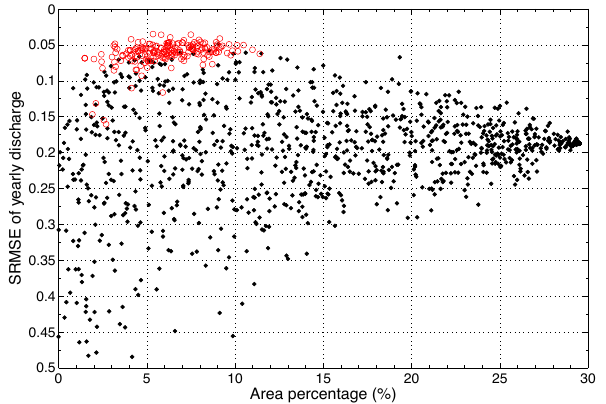
Fig. 6. Quality of discharge extrapolation measured by SRMSE of yearly discharge between gauged basin area and selected source Figure 6. Quality of discharge extrapolation measured by SRMSE of yearly discharge 3 cells, plotted against areal ratio of selected source cells to the en- between gauged basin area and selected source-cells, plotted against areal ratio of selected 4 tire gauged basin area. Two different source-cell selection methods source-cells to the entire gauged basin area. Two different source-cell selection methods are 5 are plotted: (1) randomly combining source sub-basins (black) and plotted: 1) randomly combining source-sub-basins (black) and 2) using the scale- 6 (2) using the scale-extrapolation method, i.e. allowing a sub-set of a sub-basin to be selected (red). extrapolation method, i.e., allowing a sub-set of a sub-basin to be selected (red). 7